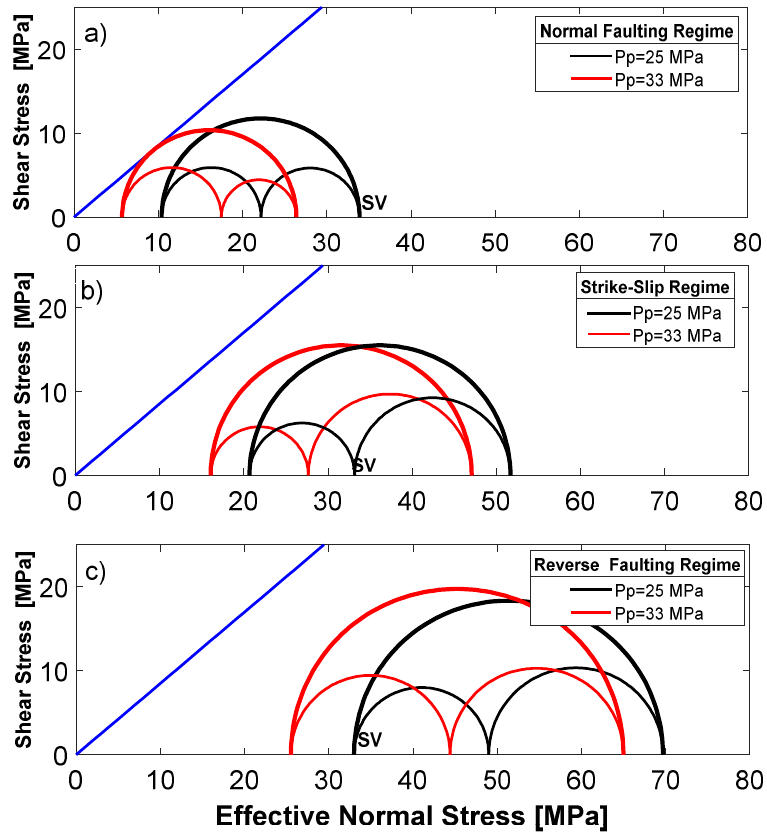
Figure 6. Mohr’s Circle in three dimensions showing the effect of fluid injection (for pressure difference, ∆ P = 8 MPa) at different states of stress: ( a ) normal faulting, ( b ) strike-slip, and ( c ) reverse faulting stress regimes.